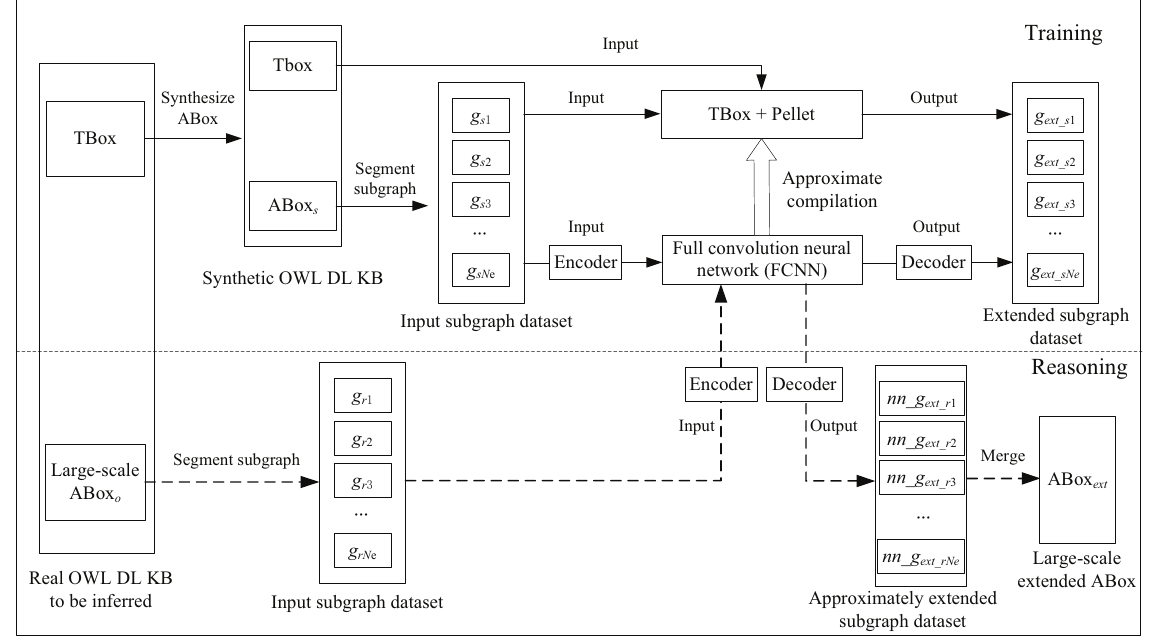
Figure 1. Overall framework of the